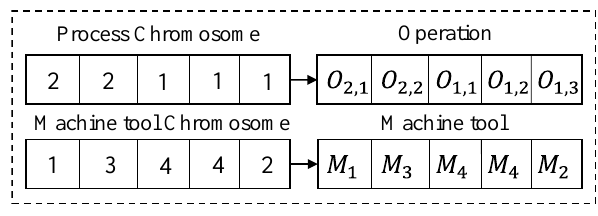
Figure 6. Chromosome encoding process.